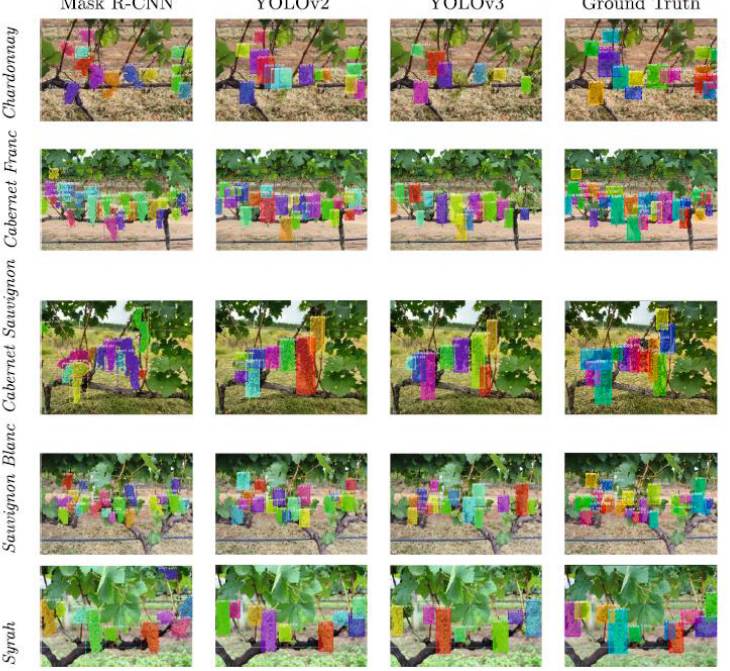
Figure 15. Example of object detection results produced by the three neural networks, namely, Mask R-CNN, YOLOv2, and YOLOv3, compared to the ground truth images, for the five grape varieties in the study. The same color does not mean correspondence [51].